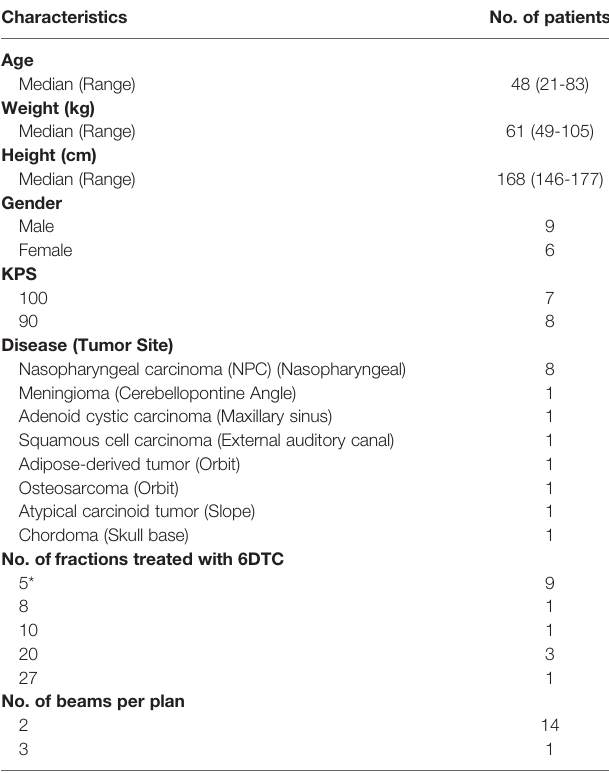
TABLE 1 | Characteristics of